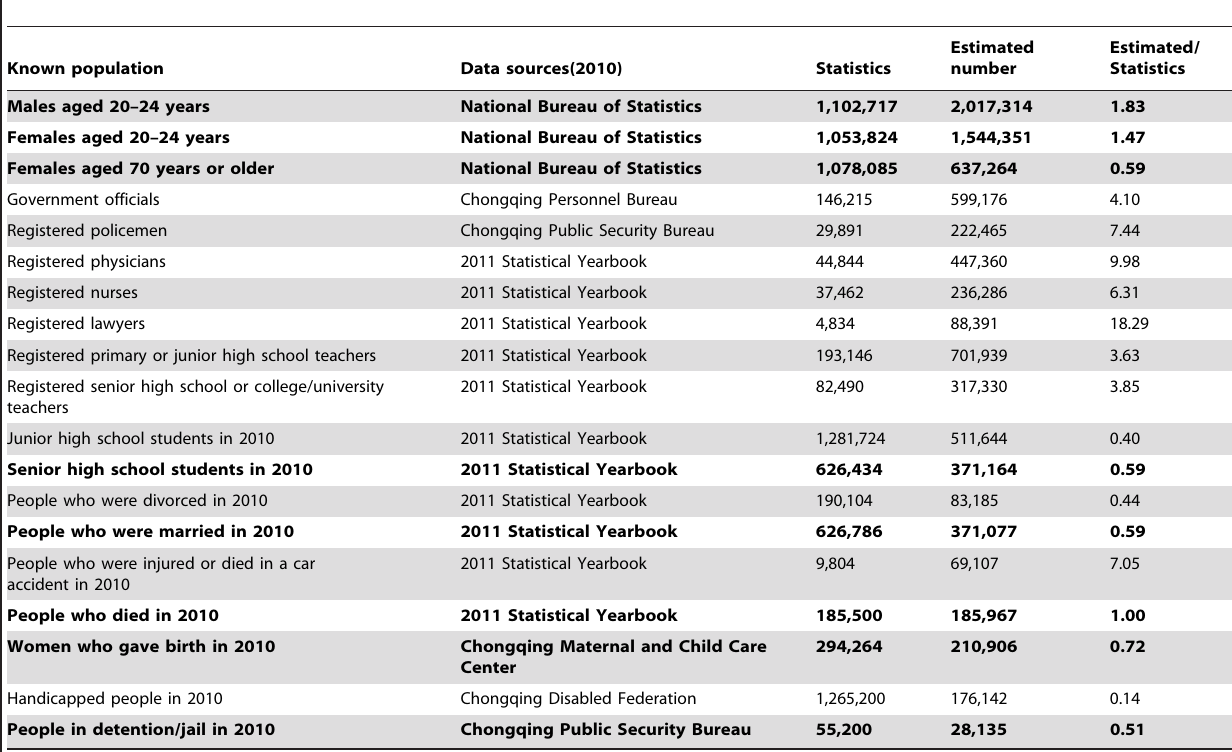
Table 1. Comparison between the official figure and estimated size of selected known populations after back estimation, Chongqing, China